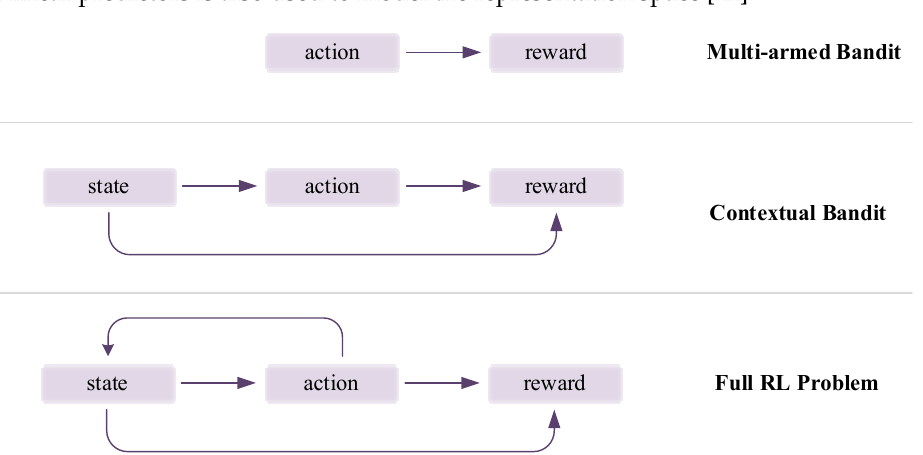
there is only a single unchanging state [20].